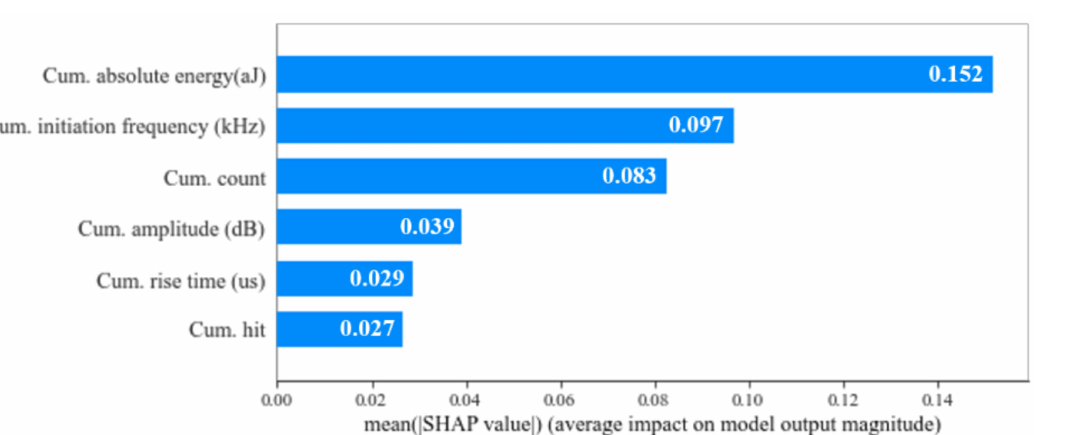
Figure 13. Force plots of specific data points in ( a ) high damage and ( b ) low damage level. In the case of a data point belonging to the high level of damage (0.99), it was confirmed that the cumulative absolute energy and initiation frequency strongly give a positive contribution to the damage value (Figure 13a). In the opposite case at which the damage value is 0.02, the above two parameters strongly offered a negative contribution to the damage value (Figure 14b).